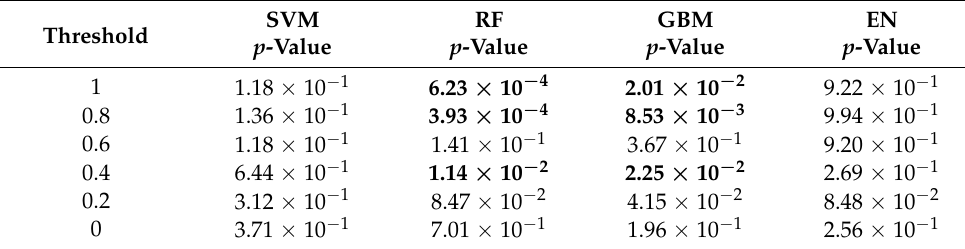
Table 3. Enrichment test of the predicted targets for RA.